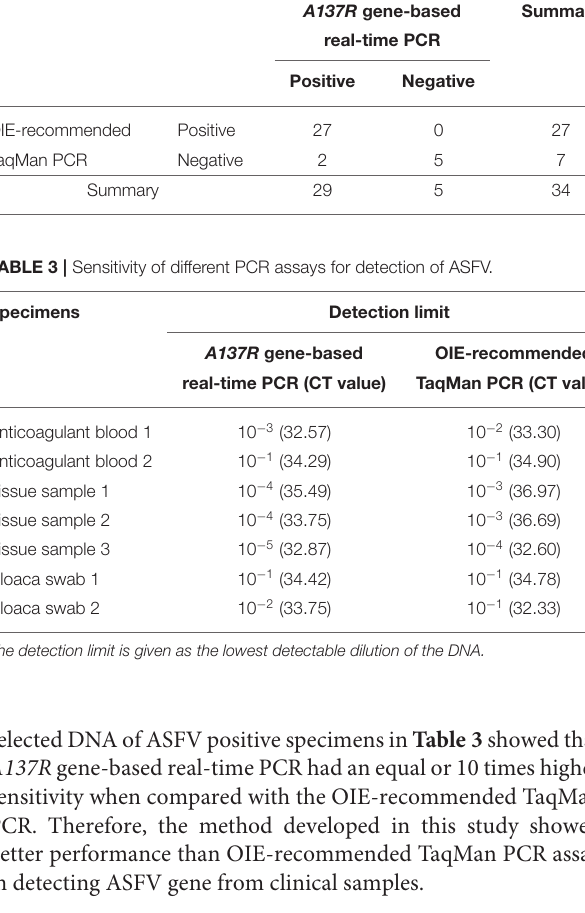
TABLE 2 | Comparison of detecting clinical samples by A137R gene-based real-time PCR and OIE-recommended TaqMan PCR. A137R gene-based Summary